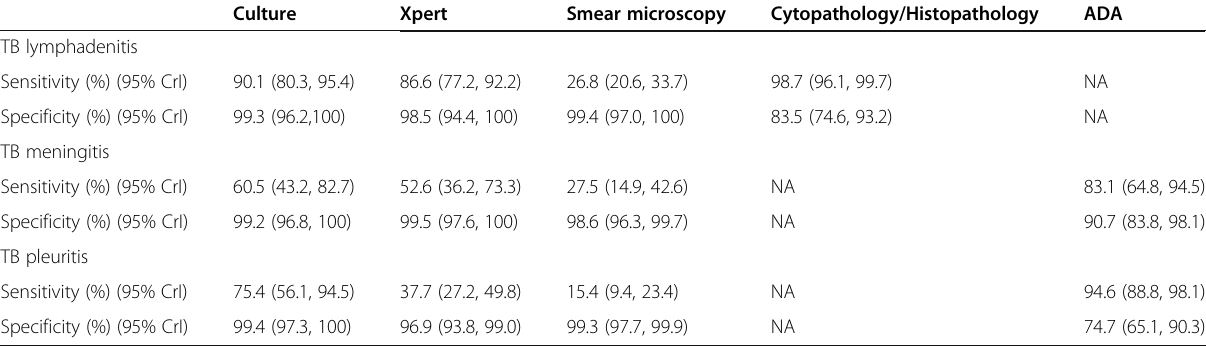
Table 1 Bayesian latent class analysis-derived diagnostic accuracies of tests for each form of extrapulmonary TB